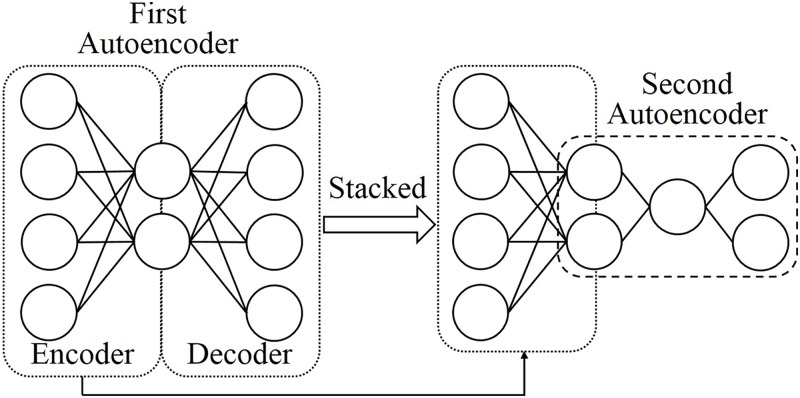
Stacked autoencoder.